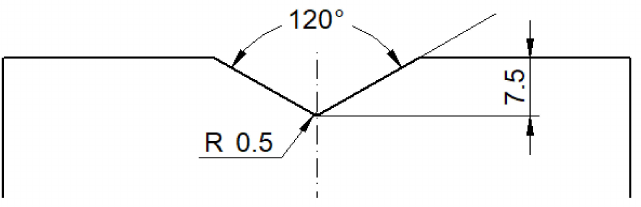
Figure 4. V-shape die geometry (the dimensions are in mm).